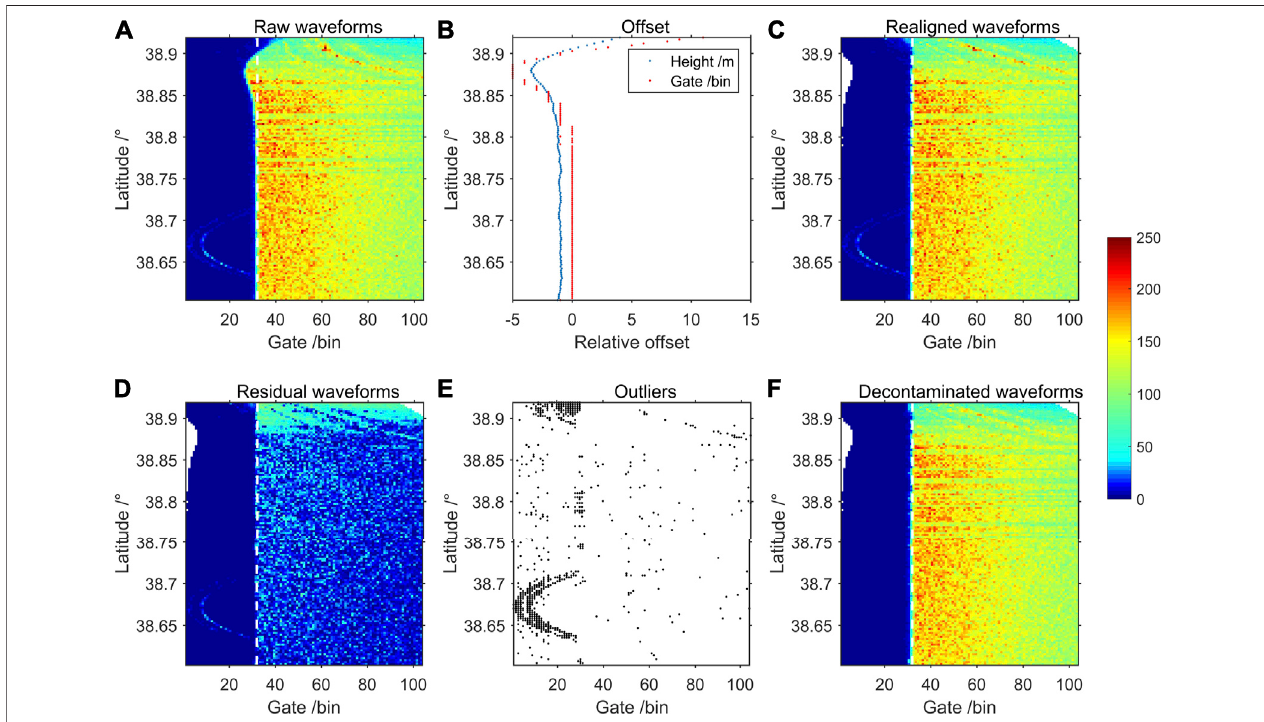
FIGURE 2 | Illustration of the waveform contamination procedure using a Jason-2 coastal track (Pass #228, cycle #225). (A) Raw waveforms. (B) Translation offsetsderivedfromheightdifferences. (C) Realigned waveforms. (D) Residualwaveforms. (E) Detectedoutliers. (F) Decontaminatedwaveforms. Thewhitedashed line indicates the nominal gate of